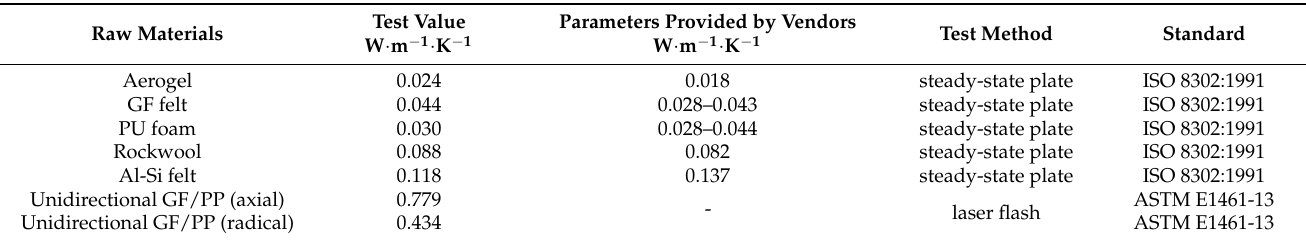
Table 3. Comparison of thermal insulation properties of different